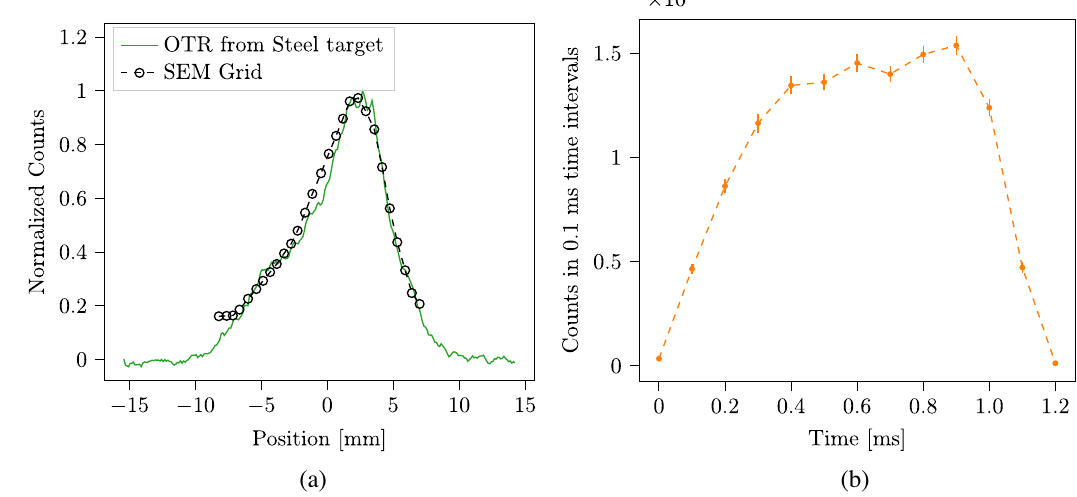
FIG. 15. (a) Comparison of a horizontal profile from a secondary electron emission grid (SEM-Grid) and OTR light for an Ar 18 þ beam with 95 μ A and 100 μ s pulse length. (b) The mean count for Fe 25 þ beam with 20 μ A average current in a 1 ms macropulse for 100 μ s MCP gate width with a varying delay marked on the x -axis. The error bars are calculated from count fluctuations over 100 macropulses.